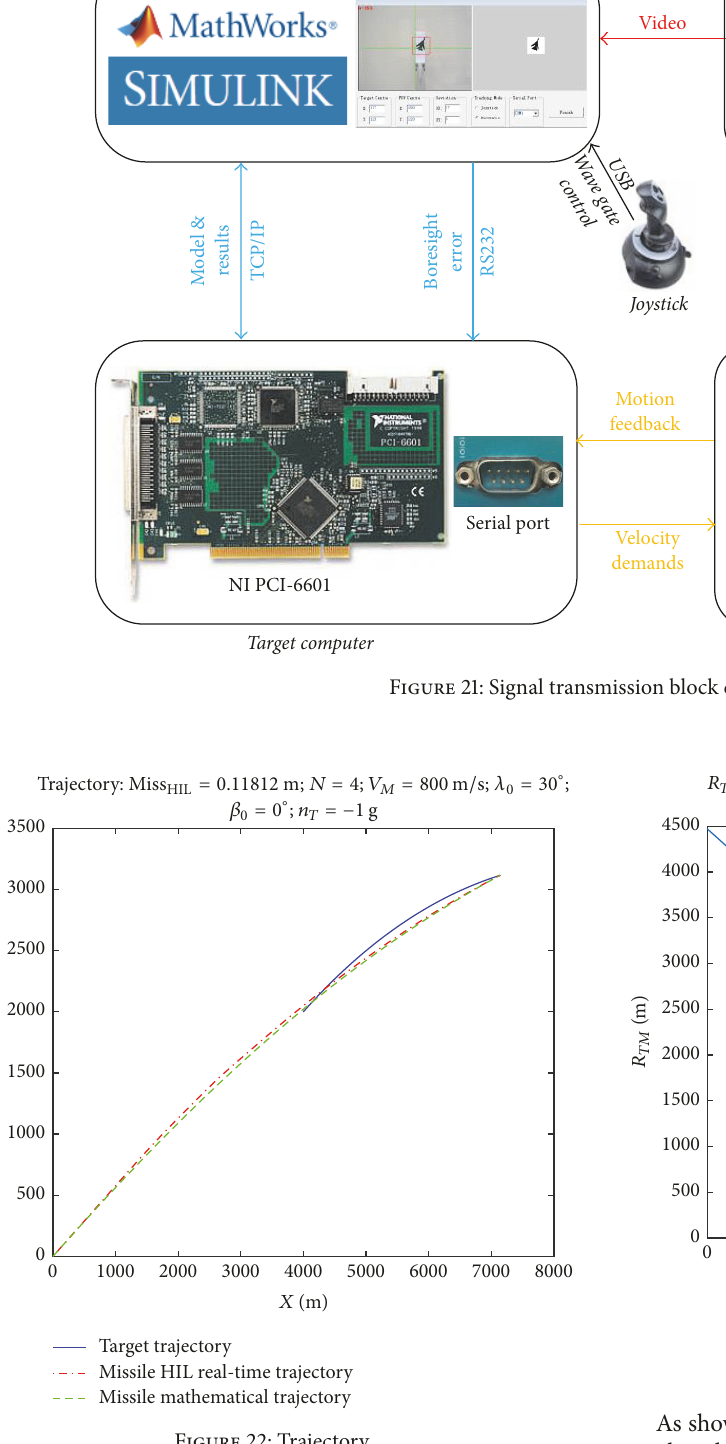
Figure 22: Trajectory.